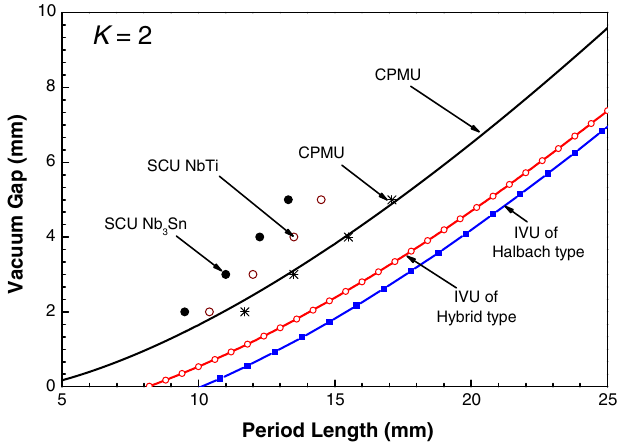
FIG. 3. Relation between vacuum gap and minimum period length for K ¼ 2 . The symbol data for CPMUs and SCUs are taken from [45], while the material for the CPMUs and IVUs is PrFeB ( Br ¼ 1 . 67 T) and NdFeB ( Br ¼ 1 . 2 T), respectively. The gap loss is assumed to be 1 mm for SCUs, and 0.2 mm for CPMU and